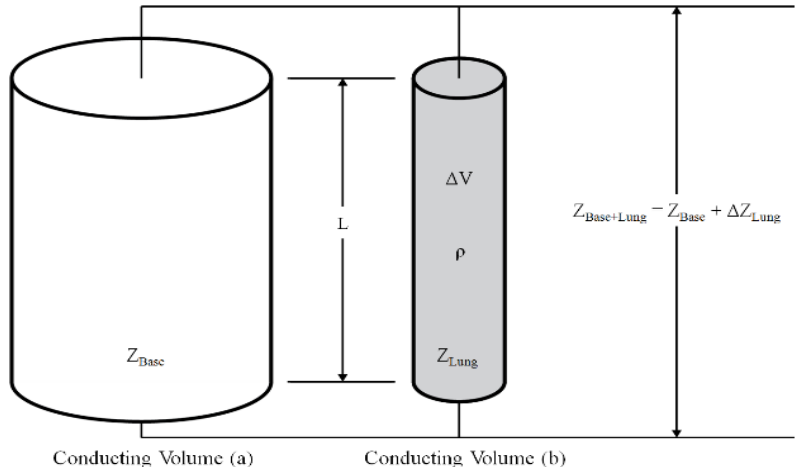
Figure 3. Parallel conducting volumes; the conducting volume ( impedance such right arm, left arm and thoracic and conducting volume ( change of the impedance of lung in